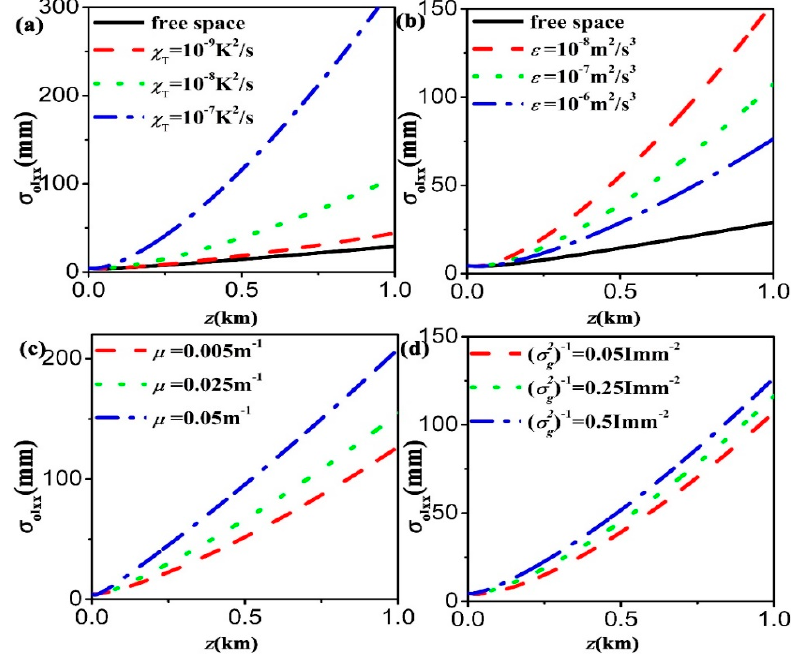
Figure 5. Evolution of the beam width σ oI xx via the propagation distances z in oceanic turbulence. ( a ) for di ff erent values of χ T ; ( b ) for di ff erent values of ε ; ( c ) for di ff erent values of the initial twist factors; ( d ) for di ff erent values of coherence widths.